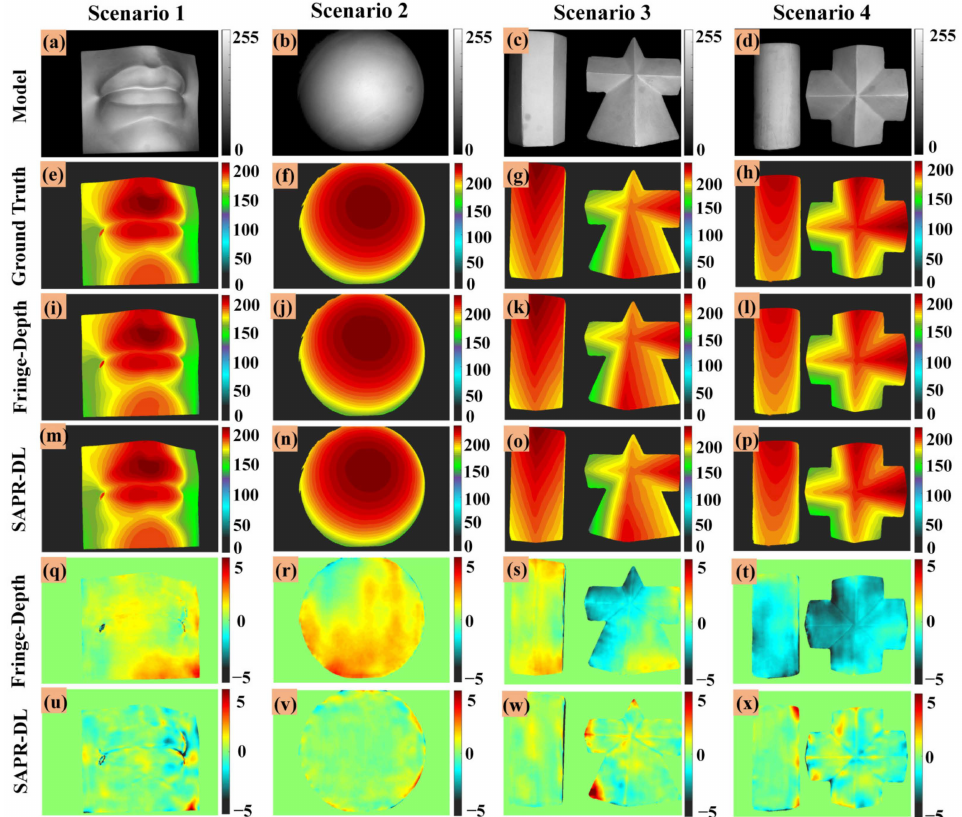
Figure 6. 3D reconstruction results based on the proposed SAPR-DL method and Fringe-Depth method. ( a – d ) Reconstructed objects. ( e – h ) Depth maps (ground truths). ( i – l ) Depth maps (Fringe- Depth method). ( m – p ) Depth maps (SAPR-DL method). ( q – t ) Depth error maps (Fringe-Depth method). ( u – x ) Depth error maps (SAPR-DL